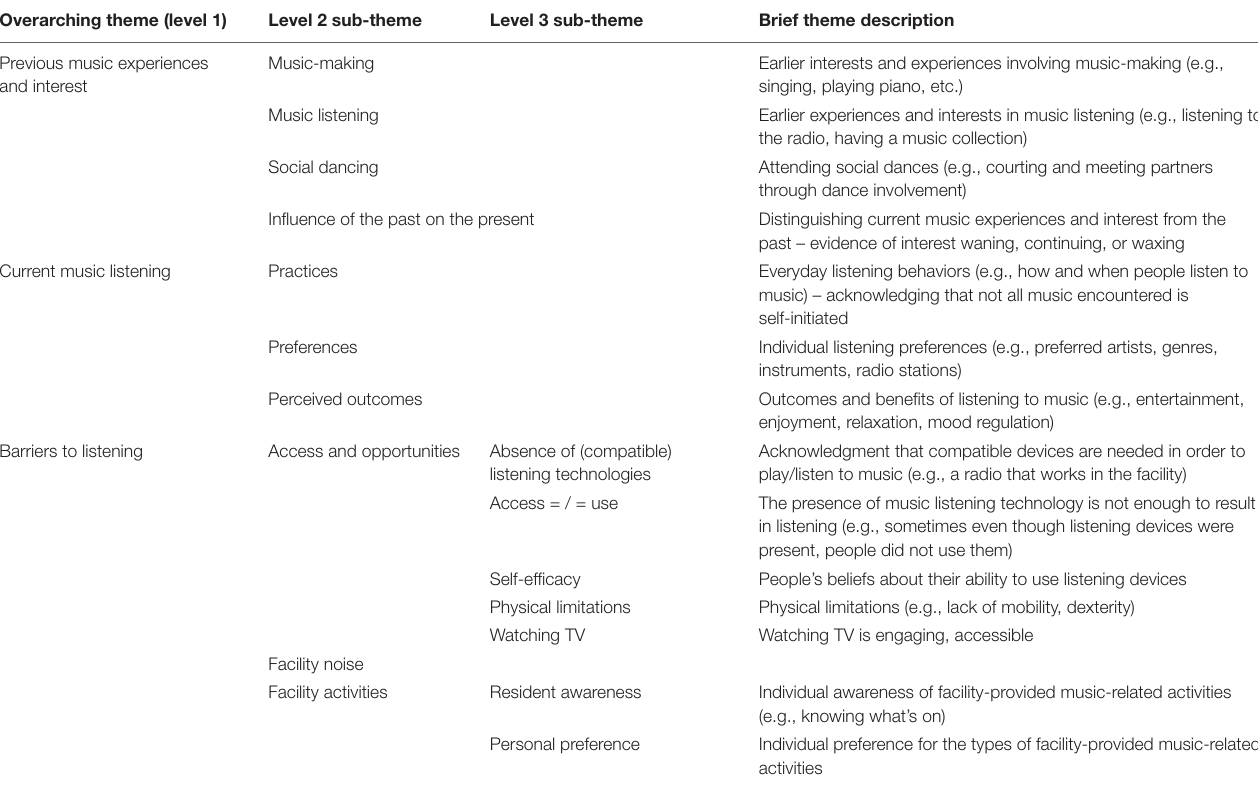
TABLE 1 | Summary of the emergent overarching and sub-themes. Overarching theme (level